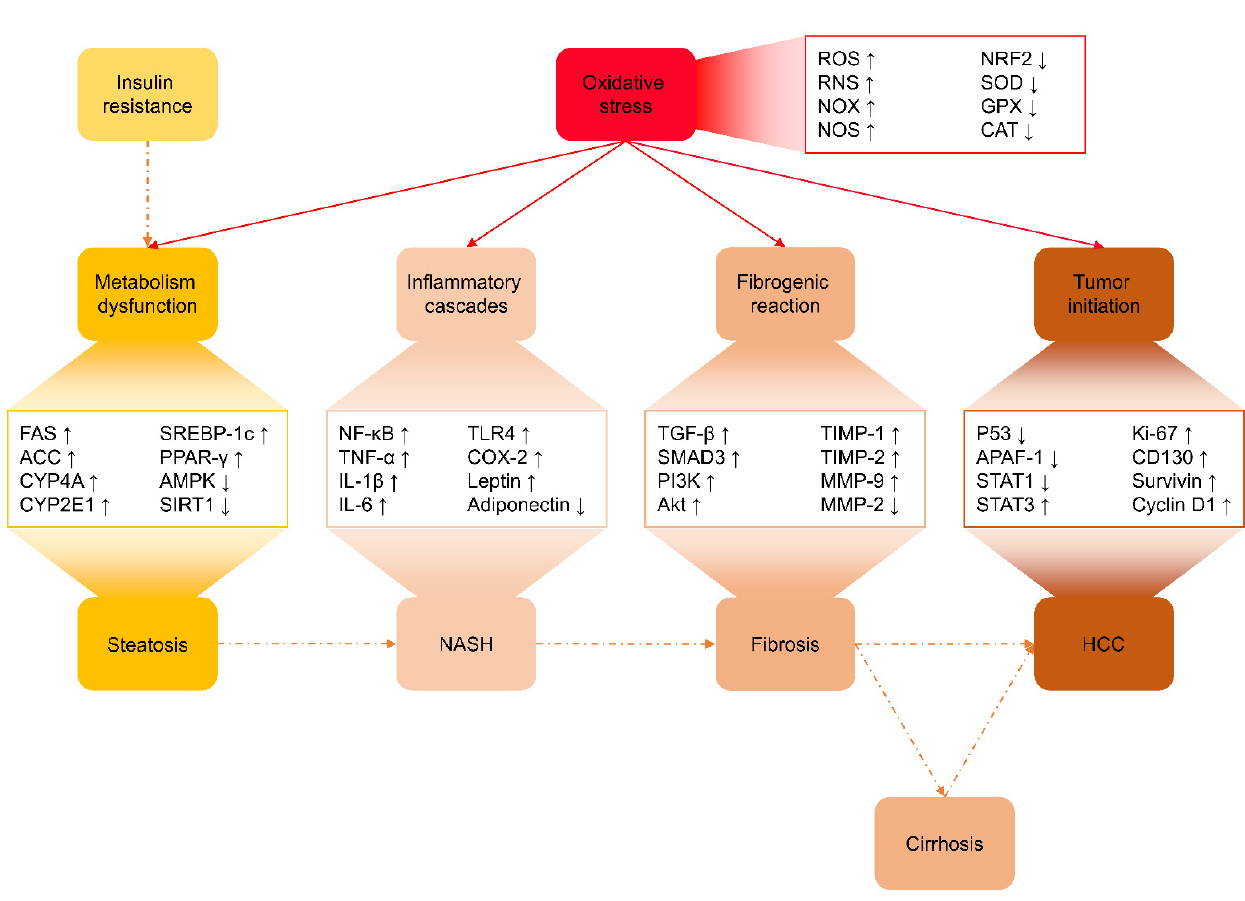
Figure 2. The crucial role of oxidative stress as a mediator, stimulator, and accelerator of other pathogenesis, including metabolism dysfunction, inflammatory cascades, fibrogenic reaction, and tumor initiation, in NAFLD progression. Of note, some of the molecules shown here may not have been mentioned in this section, but the next one. Abbreviations: ROS, reactive oxygen species; RNS, reactive nitrogen species; NOX, nicotinamide adenine dinucleotide phosphate (NADPH) oxidase; NOS, nitric oxide synthase; NRF2, nuclear factor erythroid 2-related factor 2; SOD, superoxide dismutase; GPX, glutathione peroxidase; CAT, catalase; FAS, fatty acid synthase; ACC, acetyl-CoA carboxylase; CYP, cytochrome P450; SREBP-1c, sterol element-binding protein 1c; PPAR- γ , peroxisome proliferator-activated receptor γ ; AMPK, AMP-activated protein kinase; SIRT1, sirtuin 1; NF- κ B, nuclear factor- κ B; TNF- α , tumor necrosis factor- α ; IL, interleukin; TLR4, Toll-like receptor-4; COX-2, cyclooxygenase-2; TGF- β , transforming growth factor- β ; SMAD3, small mothers against decapentaplegic 3; PI3K, phosphoinositide 3-kinase; Akt, protein kinase C; TIMP, tissue inhibitor of metalloproteinases; MMP, matrix metalloproteinase; APAF-1, apoptotic protease activating factor 1; STAT, signal transducer and activator of transcription; NASH, non-alcoholic steatohepatitis; and HCC, hepatocellular carcinoma.